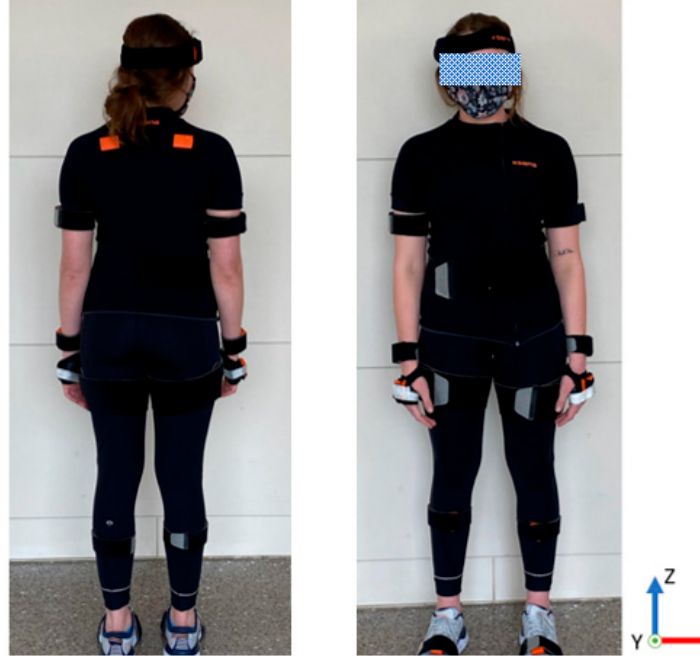
Figure 3. Full Xsens body suit used during testing.